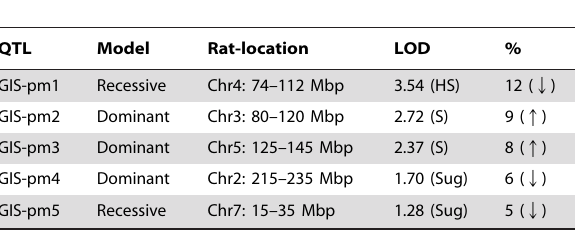
Table 1. QTLs for glomerular injury score in postmenopausal F2 (Dahl S x R) intercross female